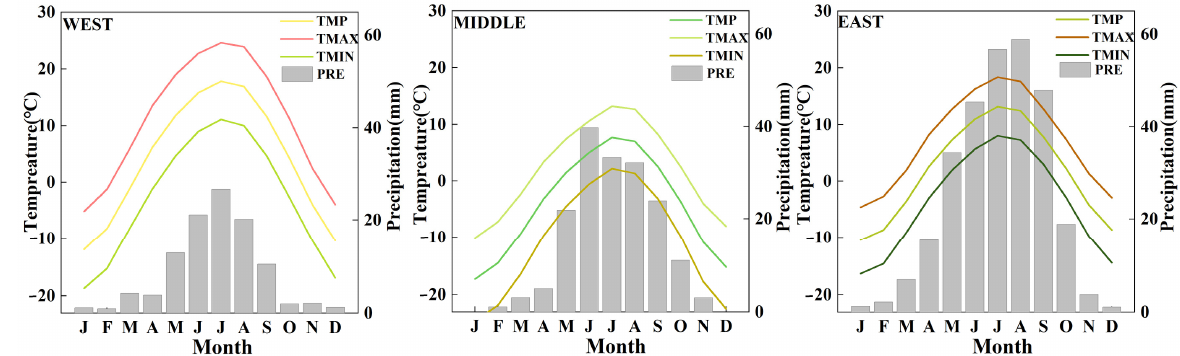
Figure 2. Monthly variability of the mean minimum temperature (TMN), mean temperature (TMP), mean maximum temperature (TMAX) and total precipitation (PRE) from 1960 to 2020.